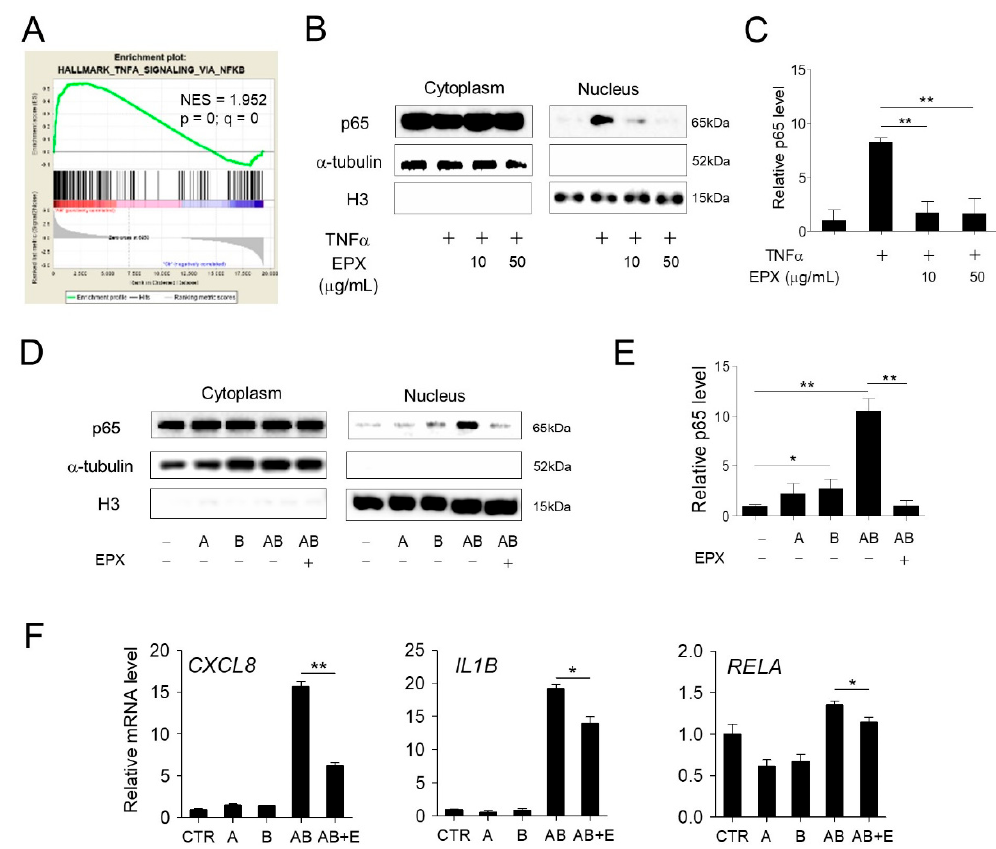
Figure 5. Eggplant extract inhibits the NF- κ B pathway activated by blue light (BL) in RPE cells. ( A ) GSEA showing that the genes modulated by BL and A2E were significantly enriched in the NF- κ B pathway. NES—normalized enrichment score. ( B ) Inhibition of NF- κ B signaling by EPX. EPX inhibited the nuclear translocation of p65 induced by TNF α in ARPE-19 cells. The p65 protein level in the cytoplasm or nuclear fraction was determined by western immunoblot using a specific anti-p65 antibody. α -tubulin and histone H3 were used as internal controls for cytoplasmic and nuclear fractions, respectively. H3—histone H3; TNF—tumor necrosis factor; EPX—eggplant extract; + —sample treatment. ( C ) Quantification of p65 level in the nucleus. The nuclear p65 level was quantified using ImageJ. The nuclear protein level of p65 was normalized to histone H3 level. The results are presented as the mean ± S.D. ( n = 3) ( D , E ) The effect of EPX on A2E+BL-induced NF- κ B pathway. EPX (25 µ g/mL) inhibited the translocation of p65 induced by BL in A2E-laden ARPE-19 cells. p65 protein level was determined and quantified, as illustrated in Figure 5B,C. A—A2E; B—blue light; AB—A2E+blue light. ( F ) The effect of EPX (25 μ g/mL) on the expression of pro-inflammatory genes determined by RT-qPCR. The mRNA levels were normalized to 18S rRNA level. CXCL8 —C-X-C motif chemokine ligand 8; IL1B —interleukin 1 beta; RELA —proto-oncogene, NF- κ B subunit. E—eggplant extract. The results are presented as the mean ± S.D. ( n = 3); * p < 0.05; ** p < 0.01.